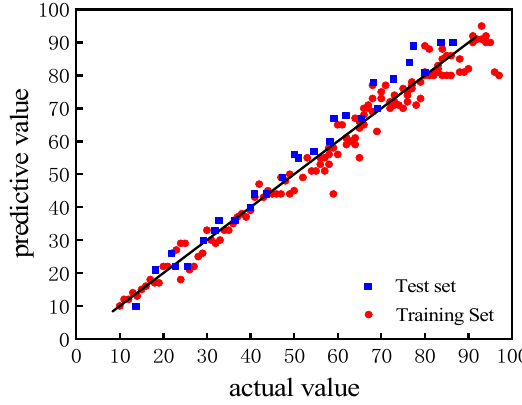
Figure 5. GA-BP neural network model error.